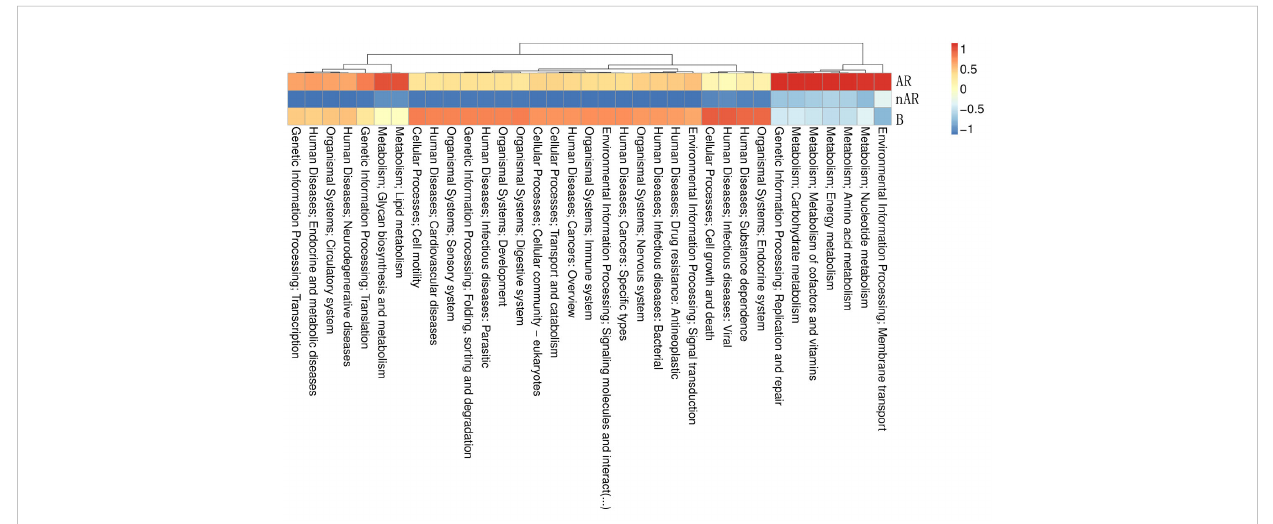
FIGURE 8 Differential analysis of speci fi c microbial functions in AR and nAR groups compared by KEGG database.